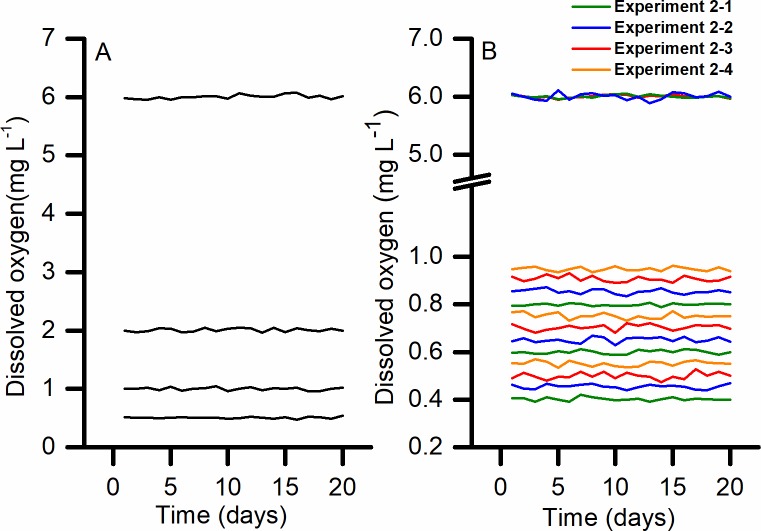
Dissolved oxygen (DO) treatments used in Experiments 1 and 2; the control group in each experiment was maintained at 6.0 mg L-1 DO.(A) Experiment 1 consisted of three treatment groups, set at 0.5, 1.0 and 2.0 mg L-1 DO, and a control group. (B) Experiment 2 comprised four independent experiments with different sets of treatments: Experiment 2.1 –treatments 0.40, 0.60 and 0.80 mg L-1 DO, and a control group; Experiment 2.2 –treatments 0.45, 0.65 and 0.85 mg L-1 DO, and a control group; Experiment 2.3 –treatments 0.50, 0.70 and 0.90 mg L-1, and a control group; Experiment 2.4 –treatments 0.55, 0.75 and 0.95 mg L-1, and a control group.